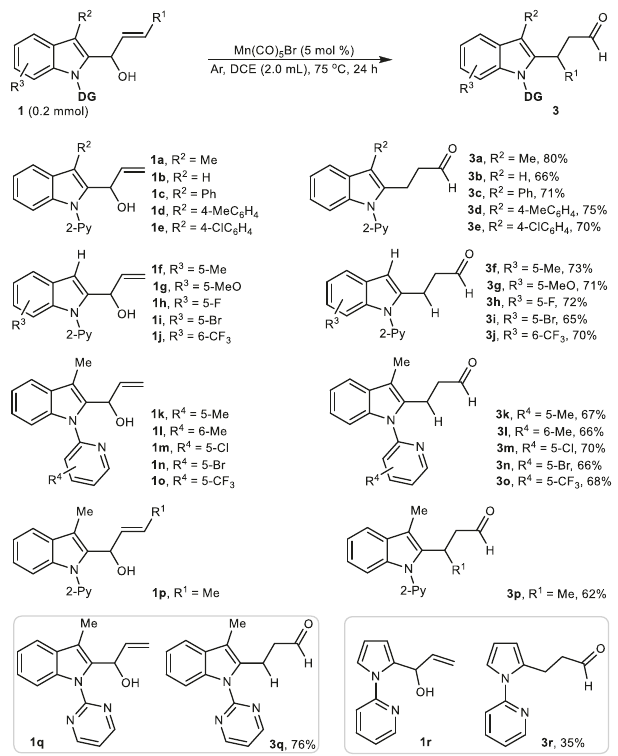
Fig. 2 | Secondary allylic-alcohol scope. All the reactions were performed in a sealed tube, followed by fl ash chromatography on SiO 2 . The yields were deter- mined by isolation.